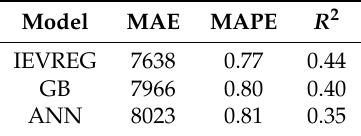
Table 5. Models performance (for MAE and MAPE lower is better, for R2 higher is